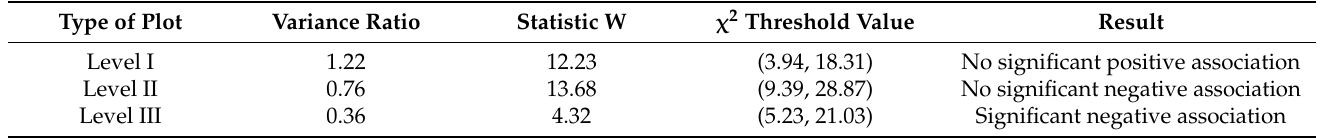
Table 2. Analysis of the overall association among the main species at different shrub-level sites.